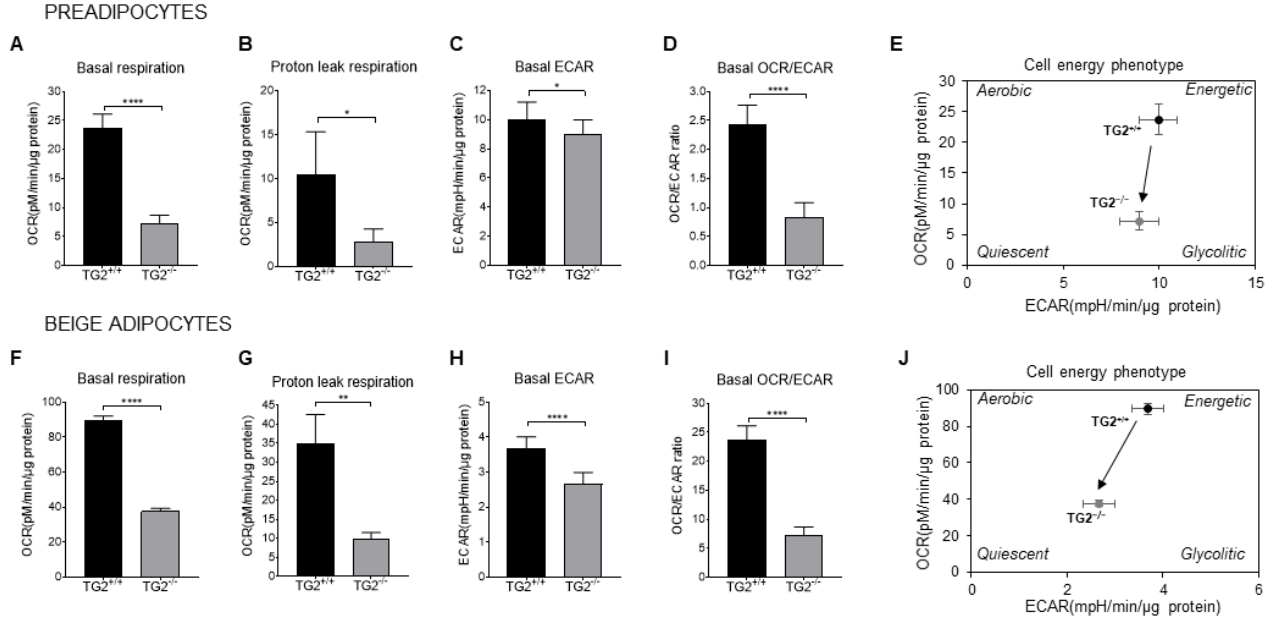
Figure 4. The bioenergetic profiles of TG2 +/+ and TG2 −/− preadipocytes and beige cells: ( A ) Mitochon- drial basal oxygen consumption rate (OCR); ( B ) proton leak OCR detected after addition of oligomycin; ( C ) basal extracellular acidification rate (ECAR); ( D ) OCR/ECAR ratio under basal conditions; ( E ) the energy phenotype profile (EPP) of preadipocytes; ( F ) mitochondrial basal OCR; ( G ) proton leak OCR detected after addition of oligomycin; ( H ) basal extracellular acidification rate (ECAR); ( I ) OCR/ECAR ratio under basal conditions; ( J ) the energy phenotype profile (EPP) of beige cells. OCR and ECAR were simultaneously measured using a Seahorse Bioscience XF-96 analyzer. Columns represent the mean values ± SD. Statistical analyses were performed using Student’s t-test. n = 4, * p < 0.05, ** p < 0.01, **** p < 0.0001.